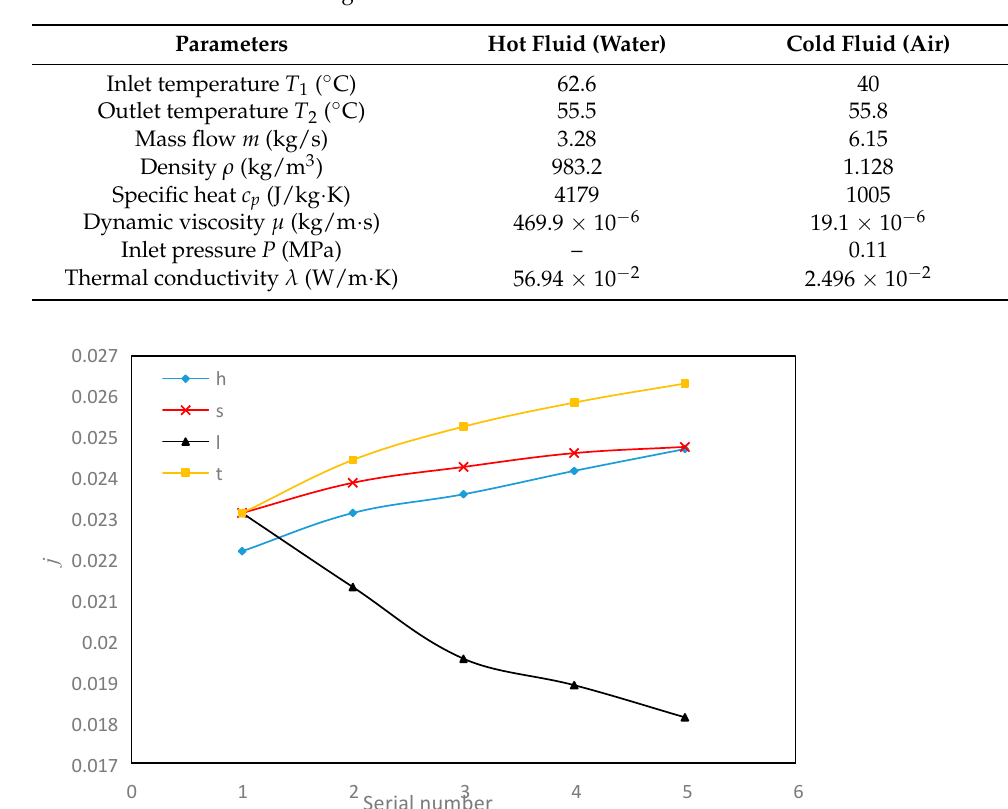
Figure 14. E ff ect of fi n structure parameter on j factor. Figure 14. Effect of fin structure parameter on j factor. The optimization results by MOGA are shown in Table 3. It can be seen that the Table 3. Comparison of optimization results under objective function. three objective functions are interrelated. In the process of multi-objective optimization, the change in each structural parameter often causes the objective function to show the opposite change trend. Therefore, multi-objective optimization is actually intended to determine an optimal “compromise point” among these objectives. Determining